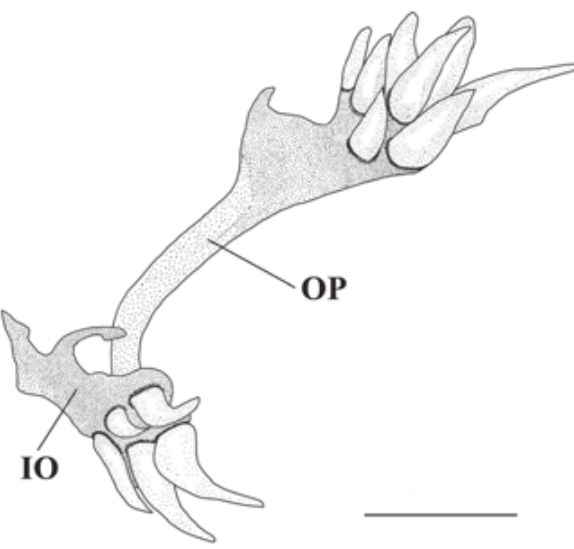
Fig. 4. Opercle and Interopercle of Trichomycterus anhanga , lateral view, left side, INPA 36117, paratype. OP = opercle; IO = interopercle. Scale bar = 0.1 mm.